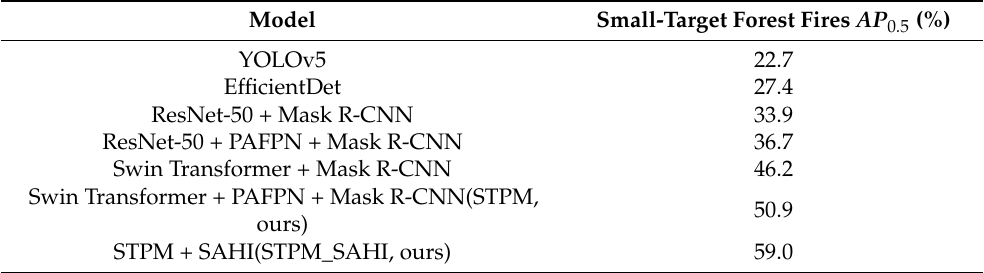
Table 6. Experimental results—detection accuracy of small-target forest fire after integrating SAHI.